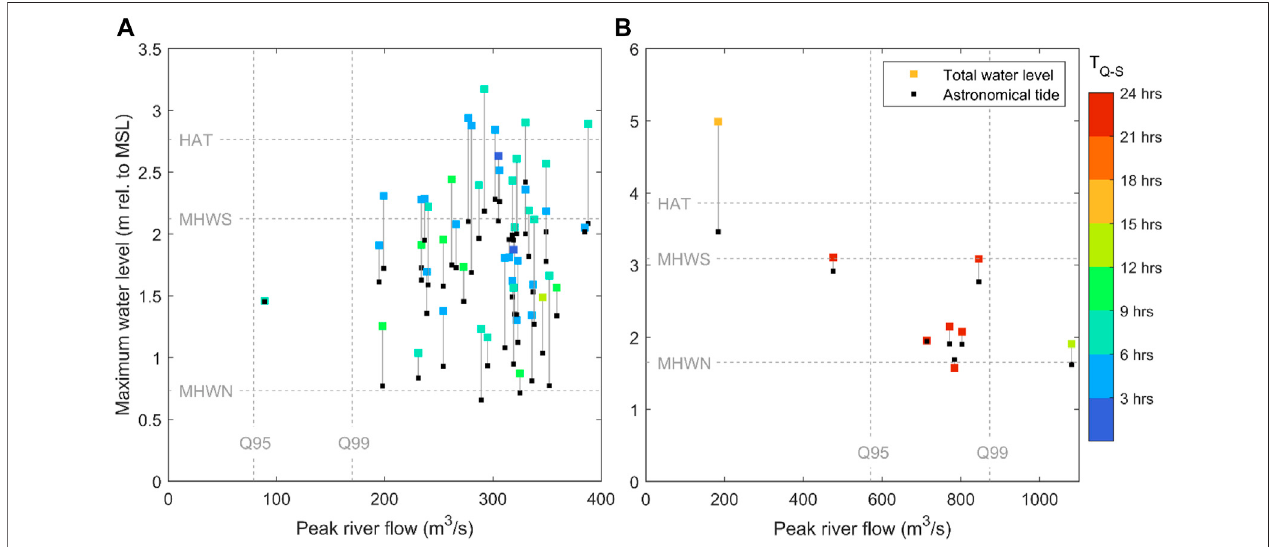
FIGURE 9 | Graphs showing the relationship between peak river fl ow (Q max ) and maximum water level (astronomical tide plus skew surge, S max ), for (A) the Dy fi based on 48 reported fl ooding events and (B) the Humber base on eight reported fl ooding events. The colour scale denotes the lag between maximum water level and peak river fl